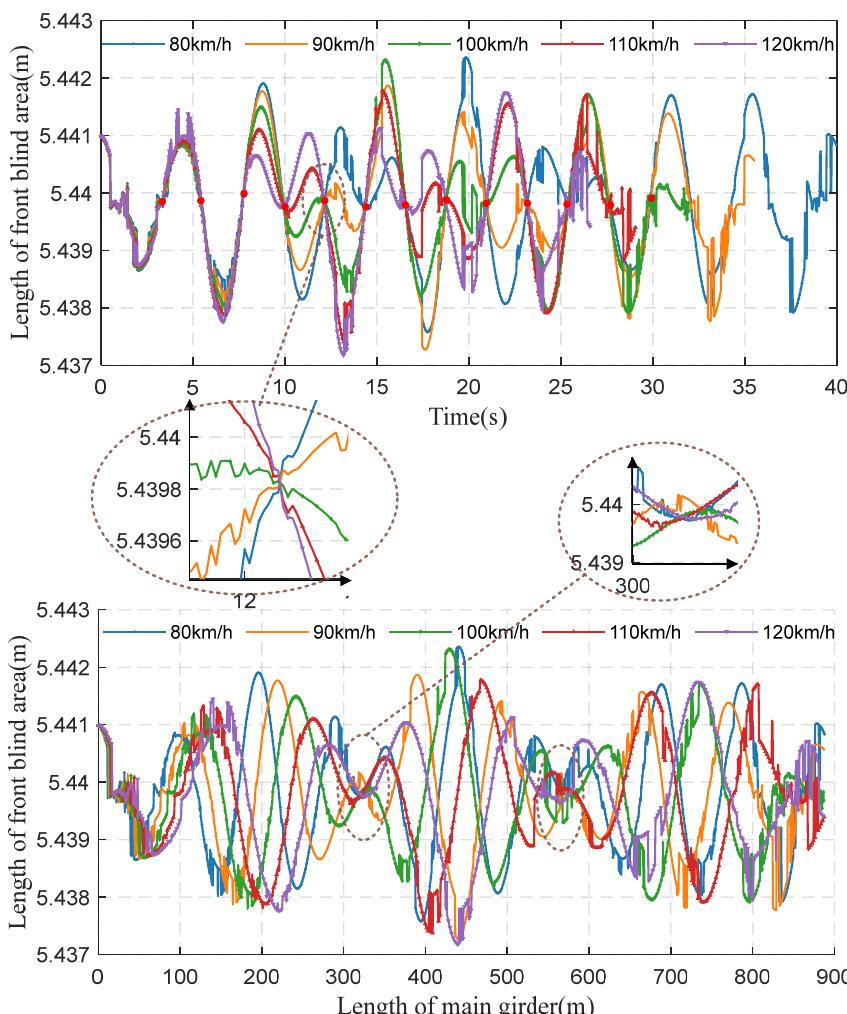
Figure 16. At 80, 90, 100, 110, or 120 km/h, the drivers’ front blind area is perceived